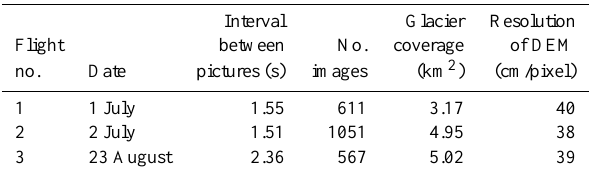
Table 1. Attributes of the flight surveys and image acquisition of the UAV.